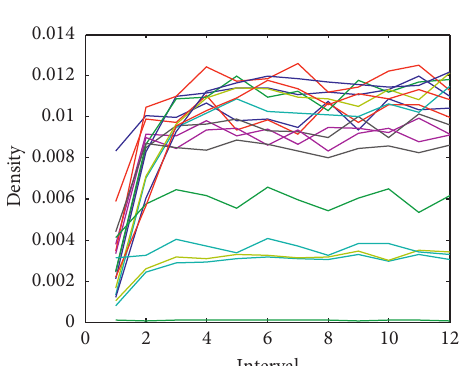
Figure 5: The density distribution with VSL.